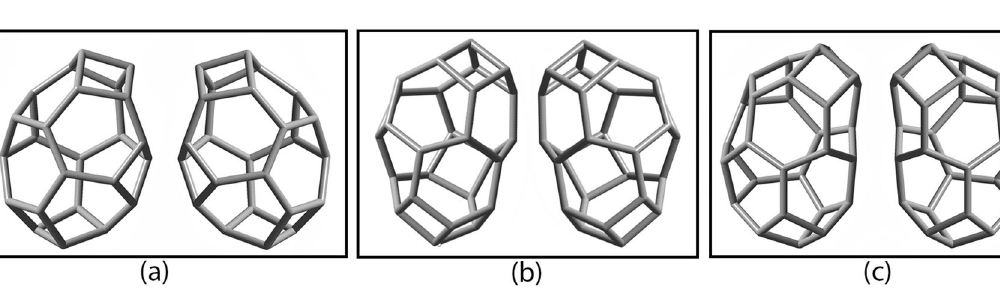
Figure 5. DFT ωB97XD/6-31G* optimized geometries of the following pairs of chiral nuggets: ( a ) nugget 24b ; ( b ) nugget 26b ; and ( c ) nugget 28b